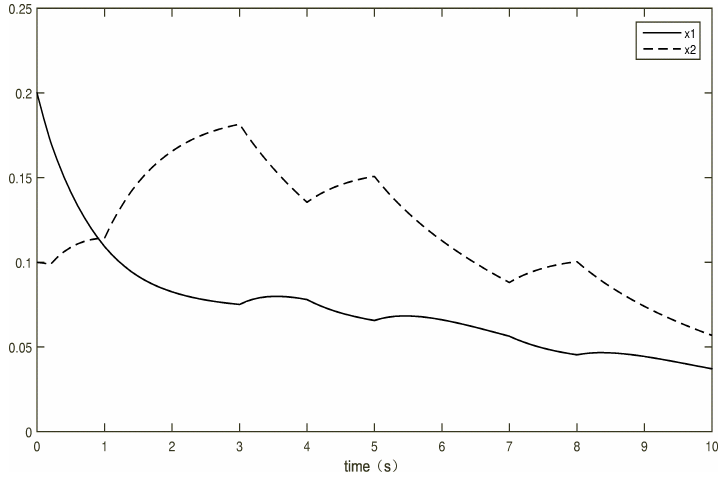
Fig. 1. State trajectories of closed-loop system